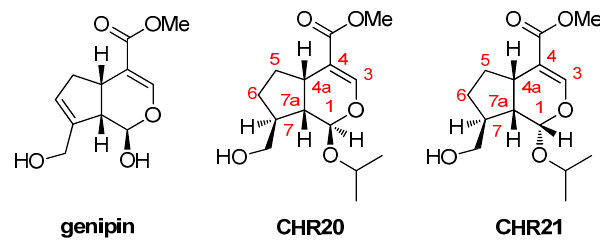
Figure 1. Chemical structures of genipin and CHR20/21 . “a” is a symbol in the IUPAC’ nomemclature rule to represent the first atom linked to the outside